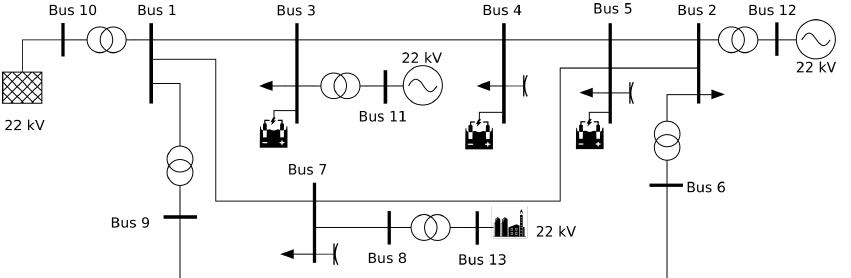
Figure 9. CIGRE high-voltage transmission grid (cf. [46]).